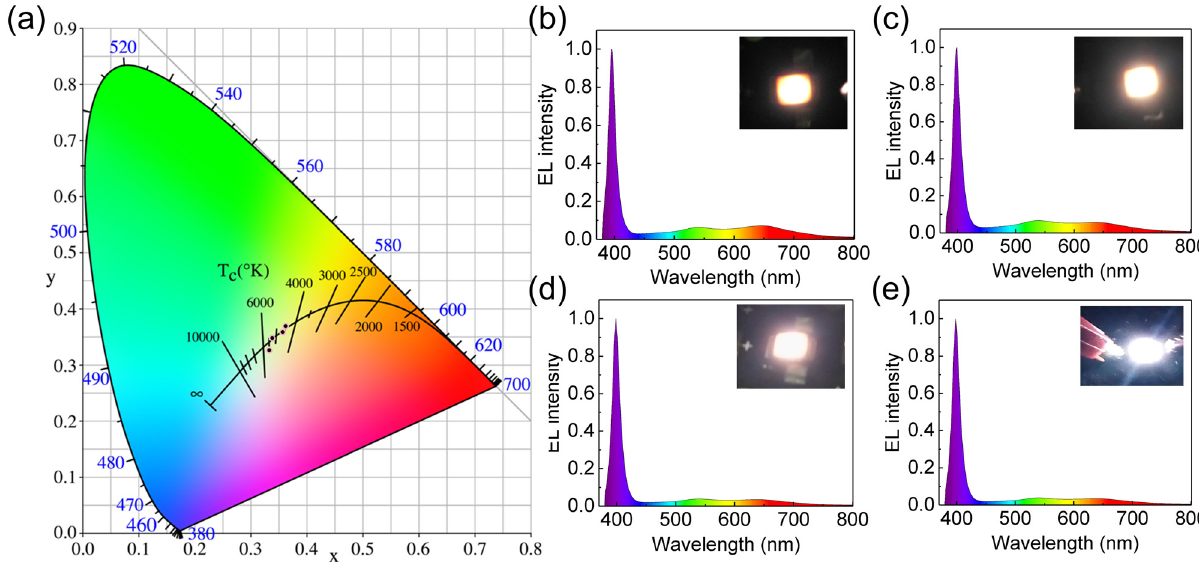
Figure 8: ( a ) The CIE coordinates of WLEDs, whose structure is composed of 0.05, 0.1, 0.2, and 0.3 g cellulose and UV LED ( 395 nm ) chip. The electroluminescence ( EL ) patterns of the WLEDs prepared with ( b ) 0.05 g, ( c ) 0.1 g, ( d ) 0.2 g, and ( e ) 0.3 g of the cellulose, respectively, insets are the working images of devices.